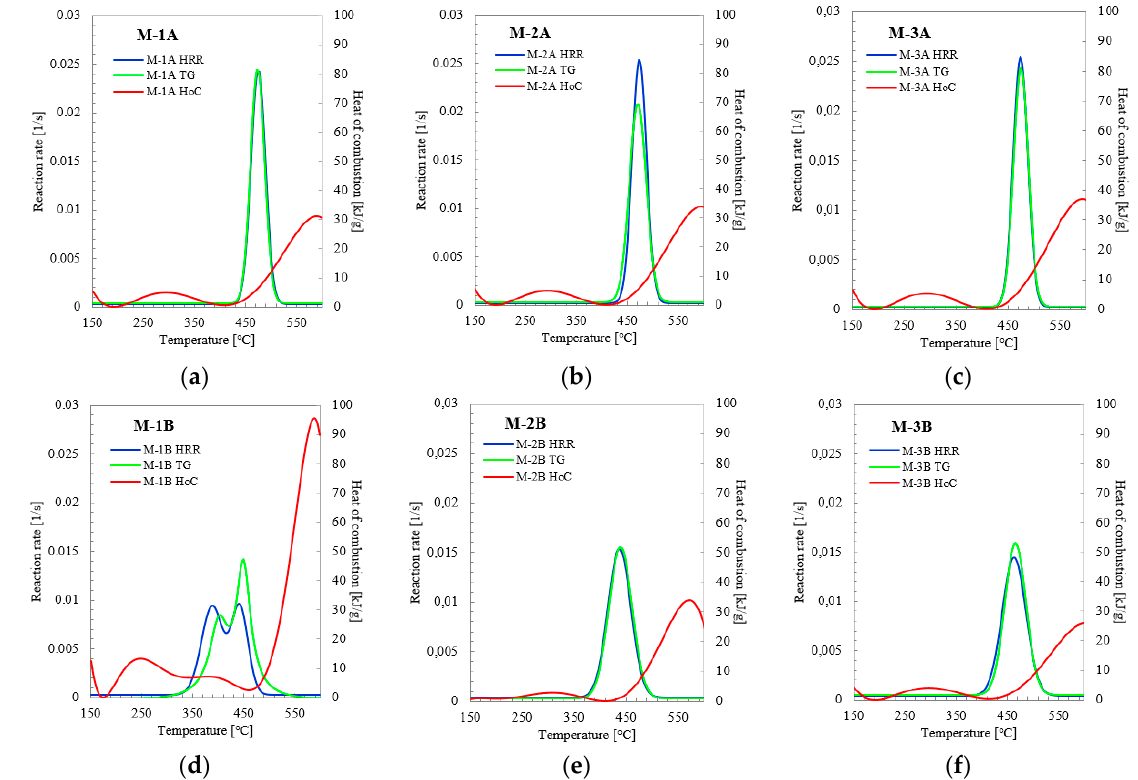
Figure 5. The dependence of the reaction rate and the heat of combustion as a function of temperature for the samples ( a ) M-1A; ( b ) M-2A; ( c ) M-3A; ( d ) M-1B; ( e ) M-2B; ( f ) M-3B. HRR—Heat Released Rate; TG—thermogravimetric analysis; HoC—Heat of combustion.